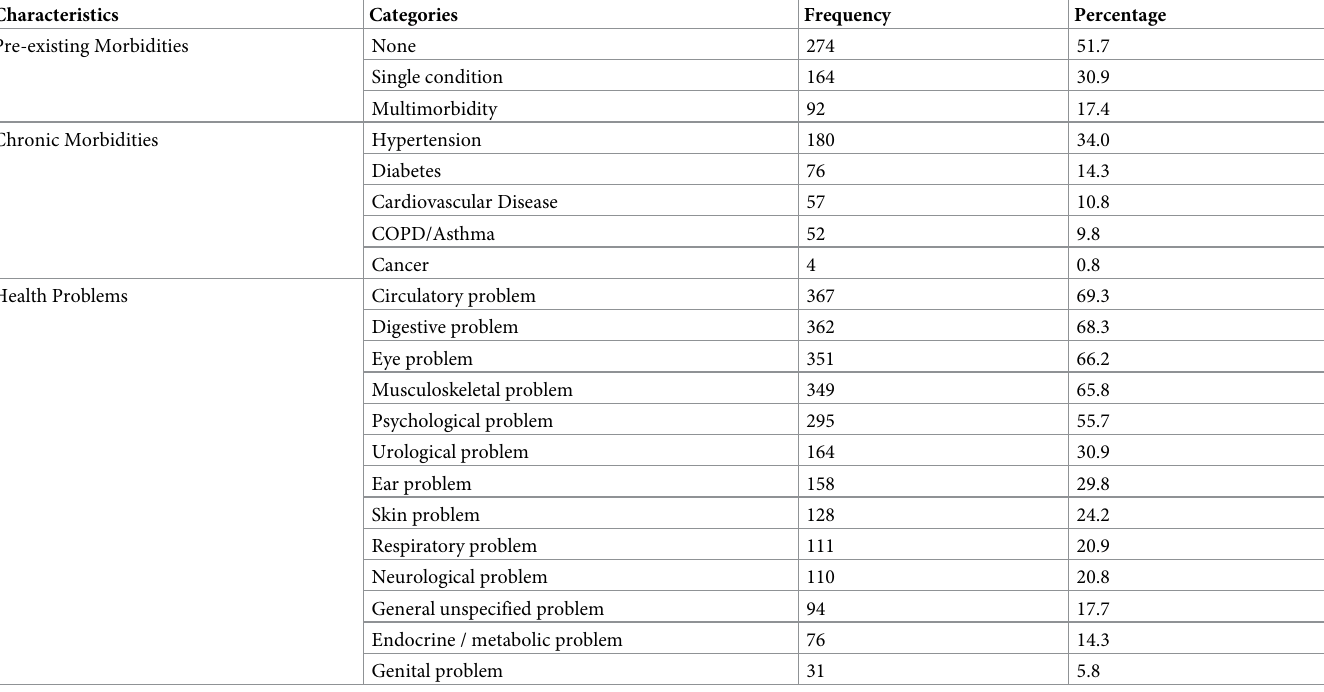
Table 2. Self-reported pre-existing chronic morbidities and health problems among the elderly [n = 530].